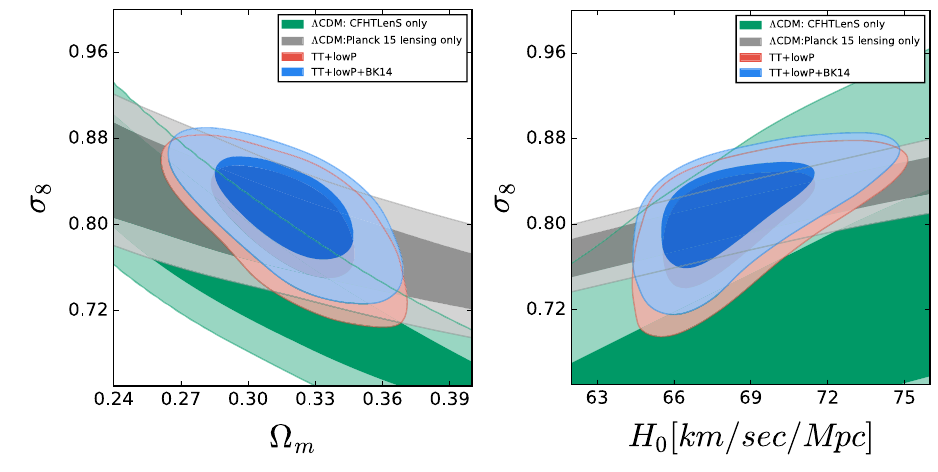
Fig. 4 1 σ and 2 σ marginalized contours for σ 8 vs. (cid:9) m and σ 8 vs. H 0 in the (cid:2) CDM + r + N + m eff eff 0 . 05